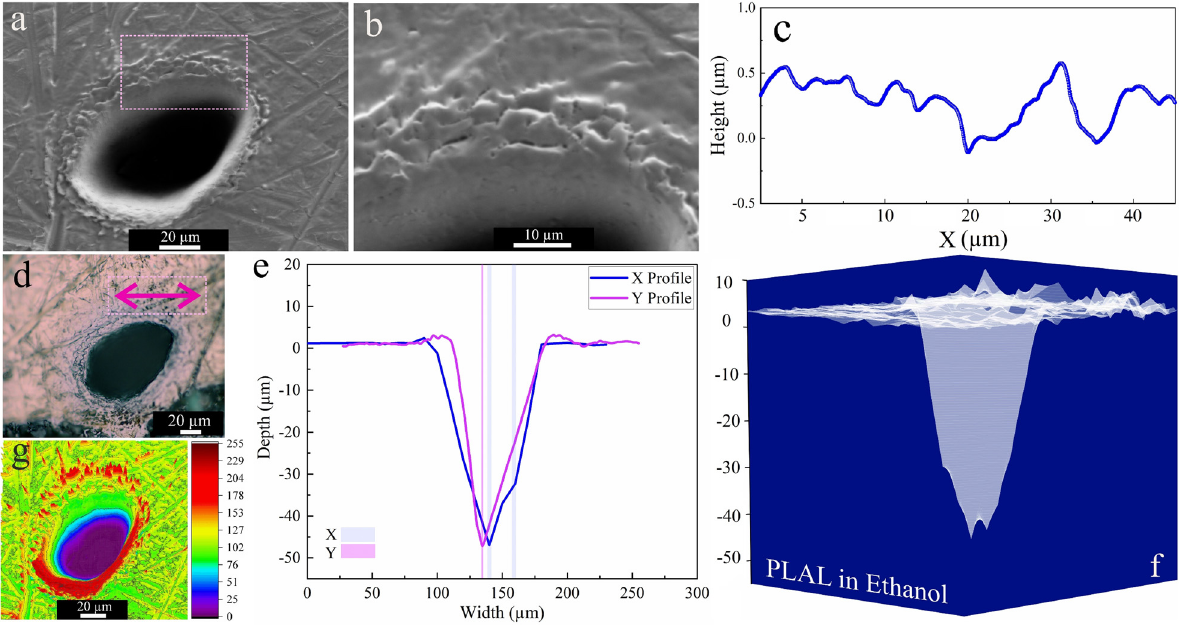
Figure 3. Morphology of a crater formed by PLAL of Au ‐ coated Ni in ethanol ( N = 1000, 1 kHz, E = 250 μ J). ( a , b ): SEM image and magnified crater edge; ( c ): a surface profile curve close to the rim; ( d ): optical microscopy of the crater (the green arrow indicates the scan of roughness); ( e , f ): depth profile analysis of femtosecond laser ‐ drilled holes and 3D mapping plot; and ( g ): 3D reconstructed image of an SEM image.